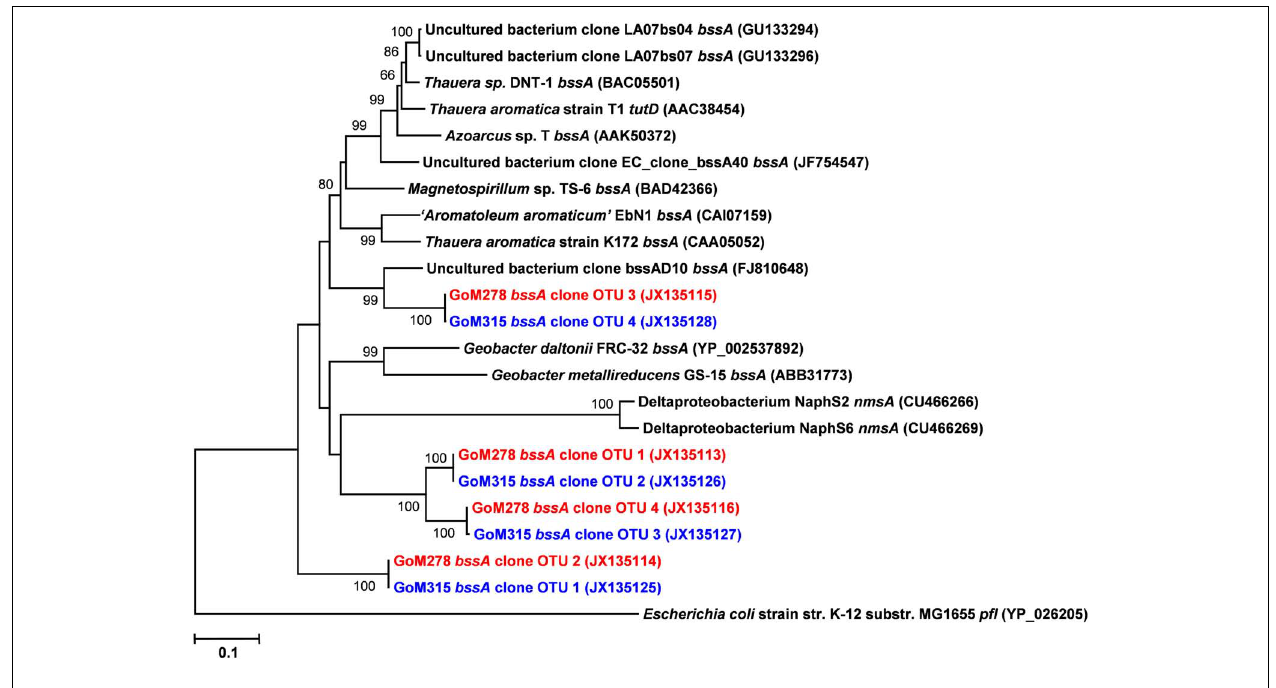
FIGURE 6 | Neighbor-joining dendrogram of bssA clone sequences obtained from GoM sediments (GoM278 – red; GoM315 – blue) compared to bssA sequences of reference strains and BLAST matches. The tree was constructed using theTajima–Nei distance method (scale bar), with pairwise deletion and performing 10,000 bootstrap replicates.